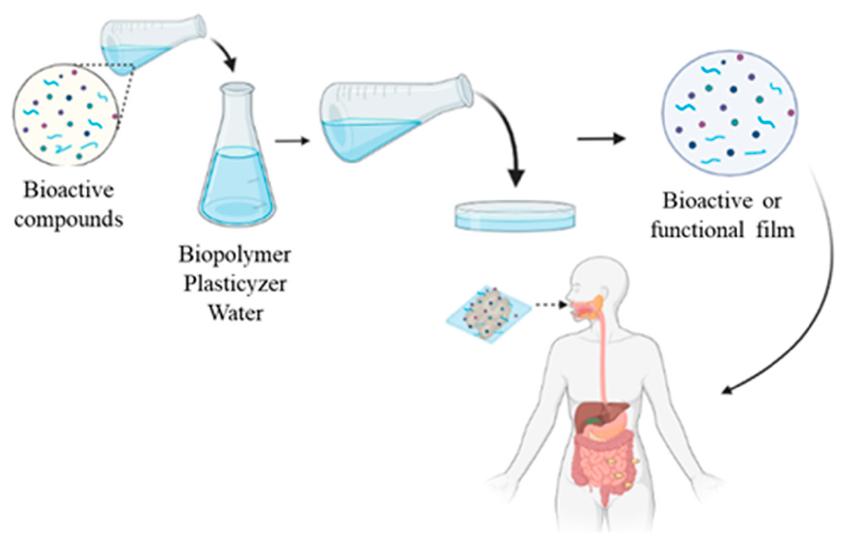
Figure 1. Overview of functional edible films and their actions.